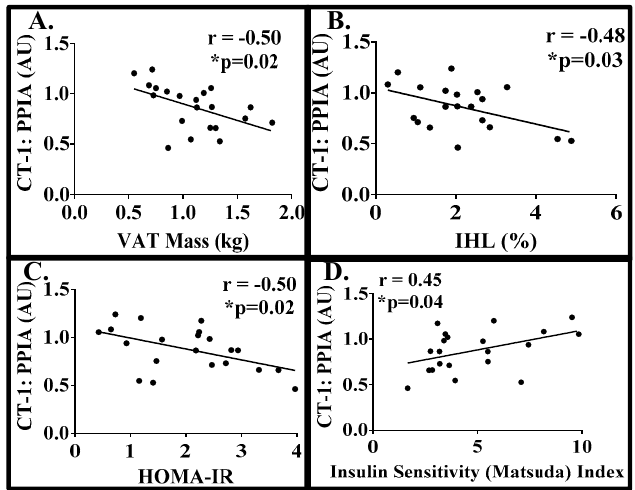
Figure 2. CT-1 scFEM expression is negatively associated with intra-abdominal adiposity, intrahepatic lipid, and HOMA-IR, and positively with Matsuda Index in women with obesity. Simple associations between scFEM CT-1 expression with ectopic fat and insulin sensitivity were analyzed using Pearson’s correlation ( N = 22). ( A ) The Pearson’s correlation between scFEM CT-1 expression and VAT mass